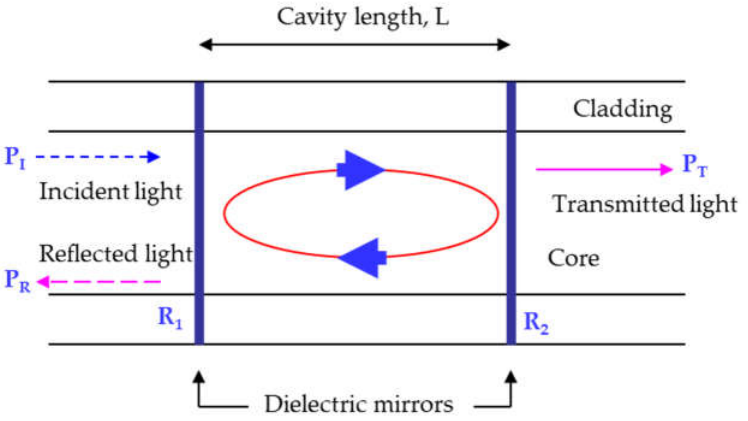
Figure 1. Illustration of a single FFPI with interior mirrors.